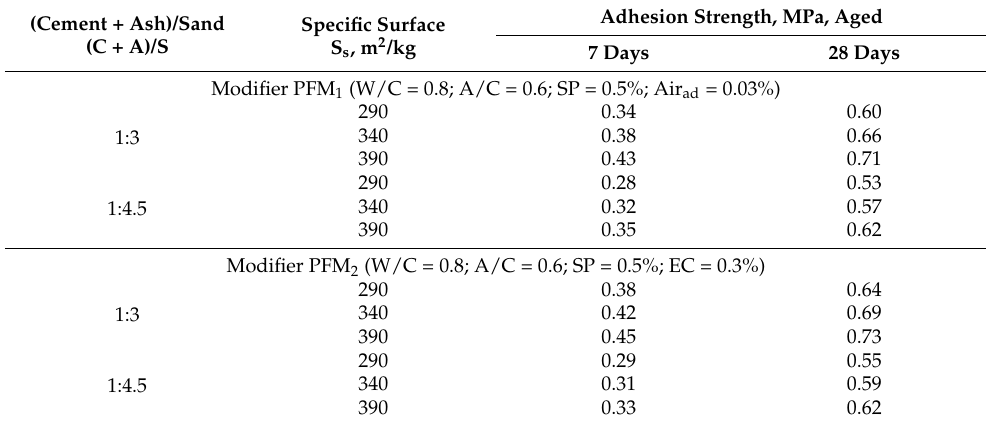
An analysis of the adhesive strength shows that the influence of both W/C and A/C